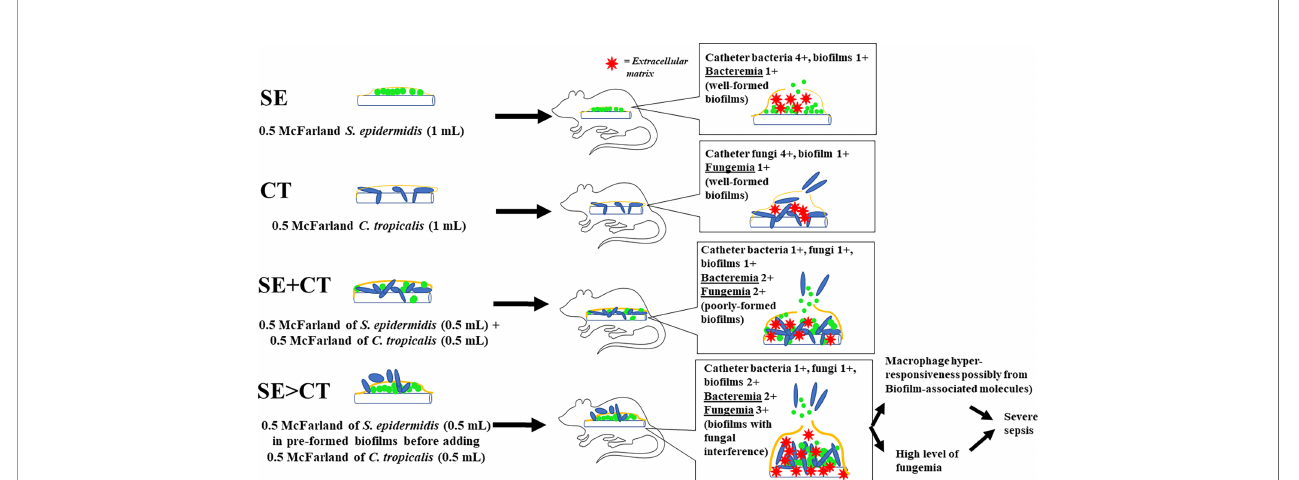
FIGURE 8 | The working hypotheses are i) the well-formed bio fi lms in catheters with the single organism, Staphylococcus epidermidis (SE) or Candida tropicalis (CT), consisting of high microbial burdens in catheters (4+) with less bio fi lm matrix (1+) leading to the low microbial burdens in blood (1+); ii) the poorly formed bio fi lms in SE simultaneously mixed with CT (SE + CT), consisting of lower organisms in catheters (1+) with similar bio fi lm matrix (1+), resulting in higher blood microbial burdens (2+) compared with single-organism bio fi lms but not enough to induce severe sepsis; and iii) fungal interference upon preformed SE bio fi lms stimulates ECM synthesis of SE with less stable bio fi lm structure causing higher fungemia (3+), macrophage hyper-responsiveness, and severe sepsis than other